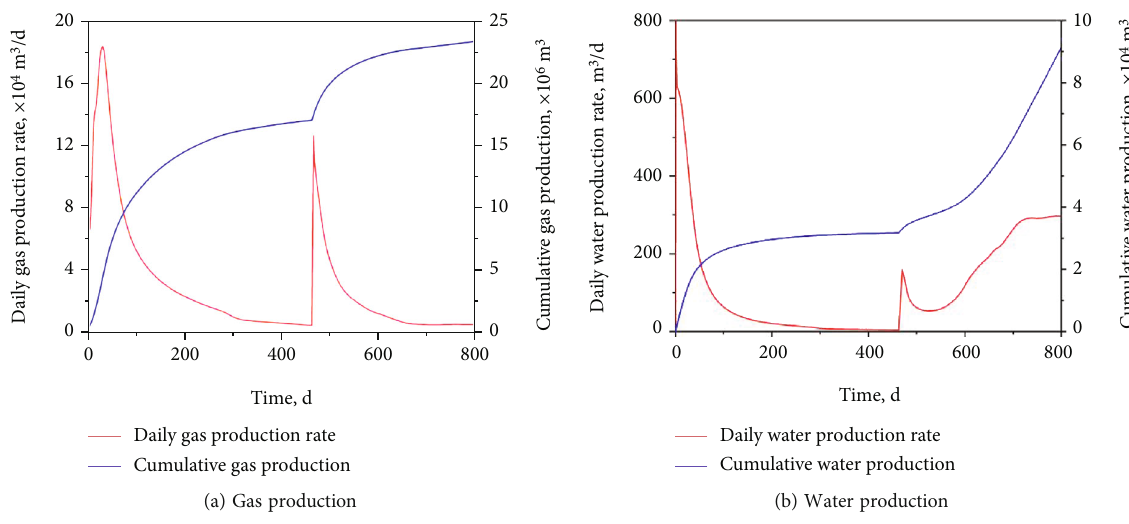
Figure 6: Gas and water production of the optimal case.